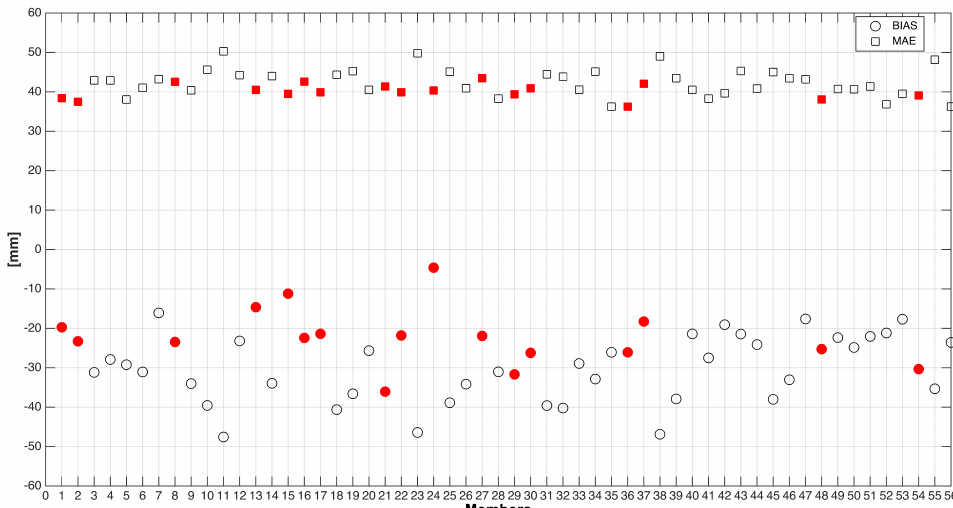
Figure 13. Rainfall depth bias and MAE for each 1km d03 WRF member. Red markers represent the 17 members, producing robust and persisting convergence lines over the Ligurian Sea.